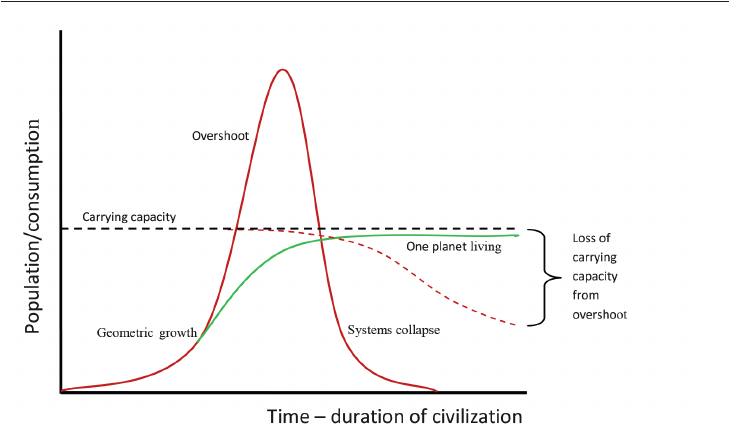
Figure 4: Alternative pathways – overshoot-to-collapse (red lines) or controlled contraction to ‘one-planet living’ well within Earth’s human carrying capacity (green